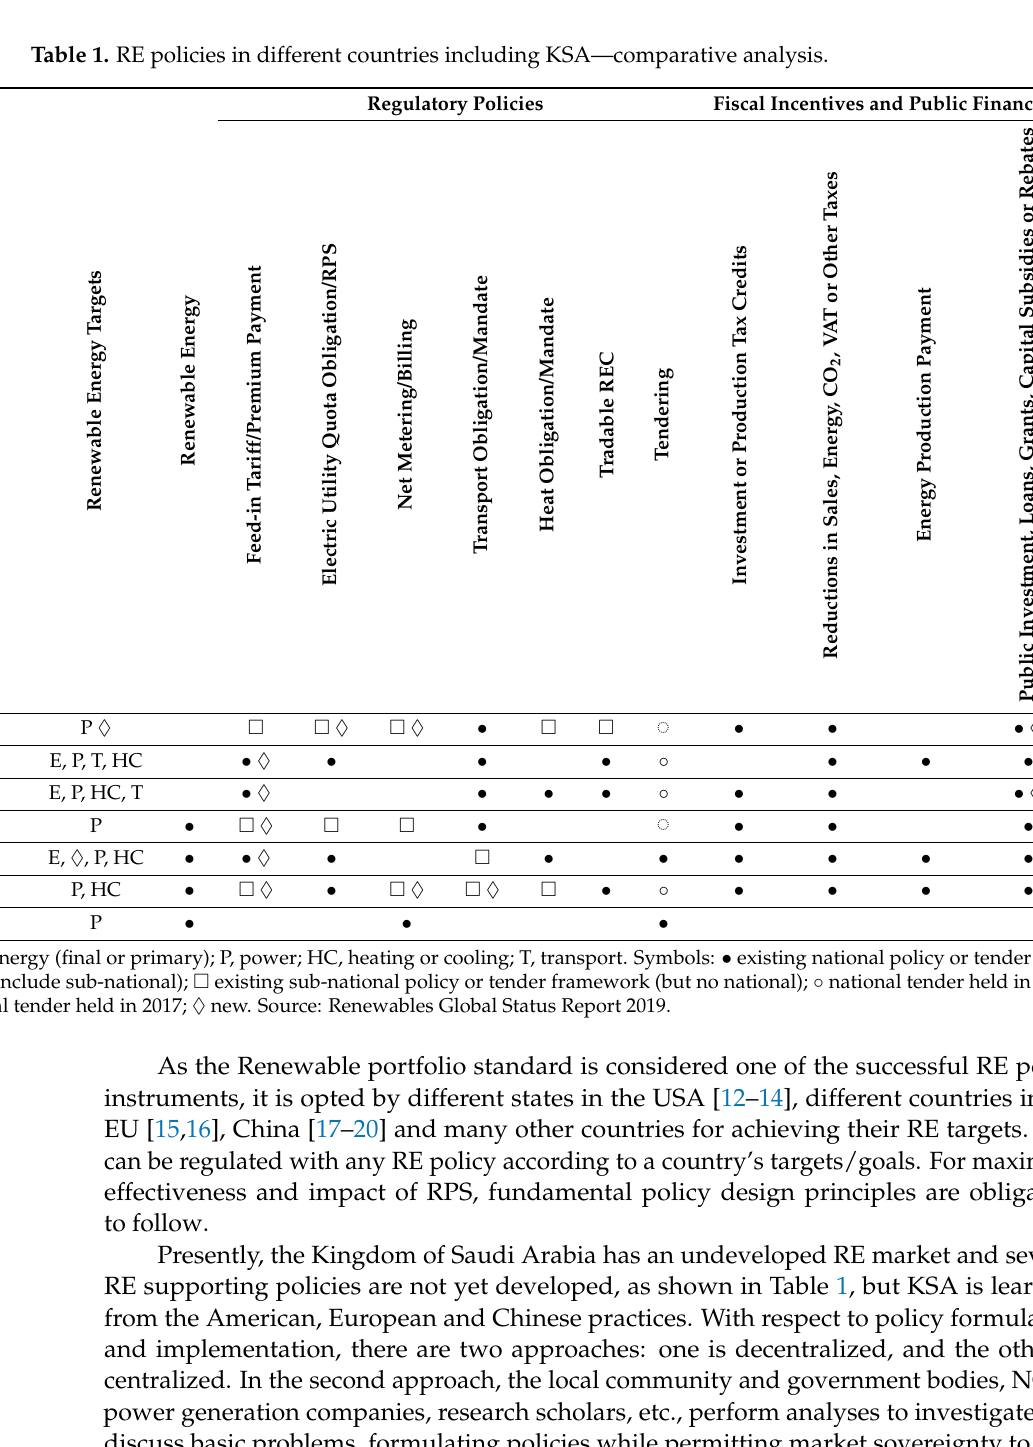
Table 1. RE policies in different countries including KSA—comparative analysis.